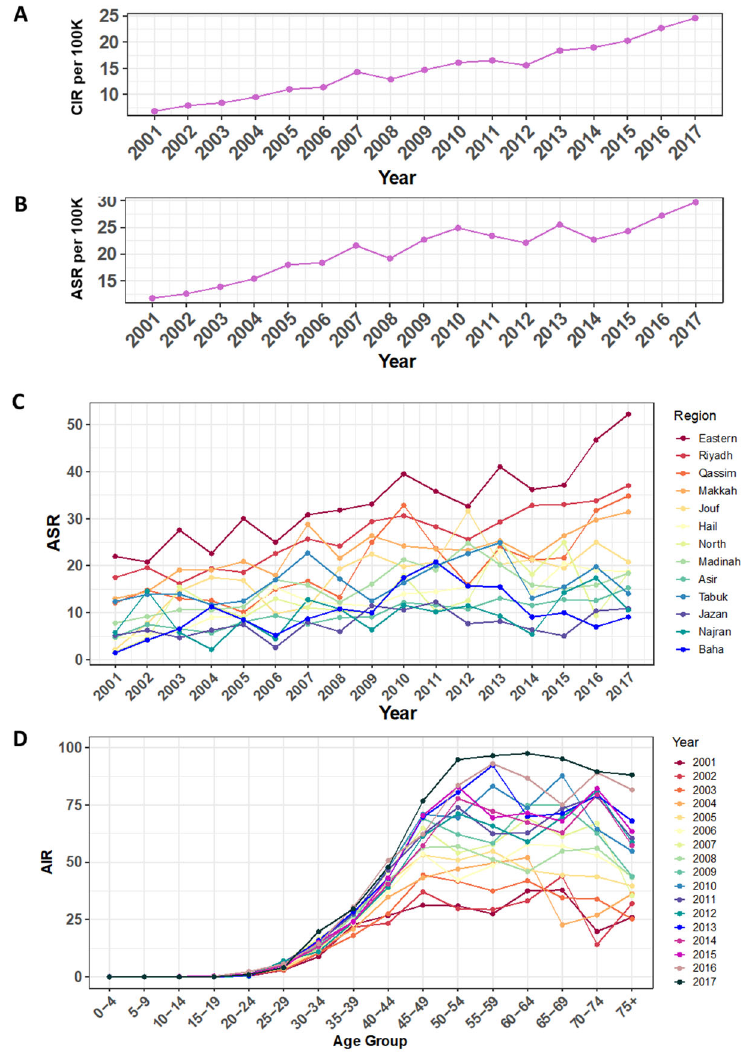
Figure 4. Incidence rates for breast cancer among the Saudi female population. ( A ) Breast cancer Crude Incidence Rate (CIR). ( B ) Overall Age ‐ Standardized Incidence Rate (ASR). ( C ) Age ‐ Standardized Incidence Rate (ASR) stratified by administrative regions in Saudi Arabia. The years for the period of 2001–2017 are indicated in the x ‐ axes. ( D ) Age ‐ Specific Incidence Rate (AIR) shown for each age group ( x ‐ axis). All rates are per 100,000 population, as indicated in the y ‐ axes.